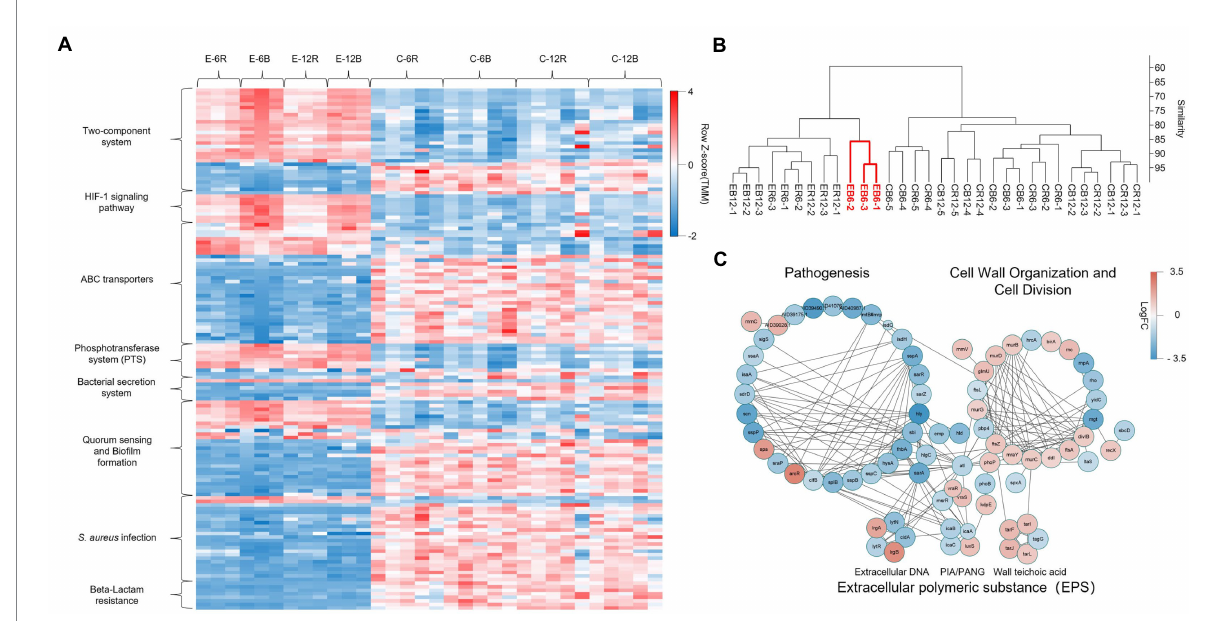
FIGURE 4 Gene expression of the MRSA biofilm cells treated for 6 h having the most distinct one among all groups. (A) Heatmap of the expression level of DEGs for selected KEGG pathways, revealing the increased signal transduction, reduced membrane transport, quorum sensing, Staphylococcus infection and β -lactam resistance in elasnin-treated samples. (B) Hierarchical clustering of the RNA-seq data by using the normalised reads count, revealing that biofilm cells exhibited the most unique gene expression pattern after 6 h of elasnin treatment. (C) Networks of DEGs of biofilm cells after 6 h of elasnin treatment and their functional associations. The nodes represent the differentially expressed genes between the control and treatment groups after 6 h of treatment, and the edges indicate their associations as predicted by STRING. Red colour indicates upregulated gene expression, whereas blue colour indicates downregulated gene expression following elasnin treatment. The size is inversely proportional to the p value, as described in the Material and Method section (a larger node corresponds to a smaller p